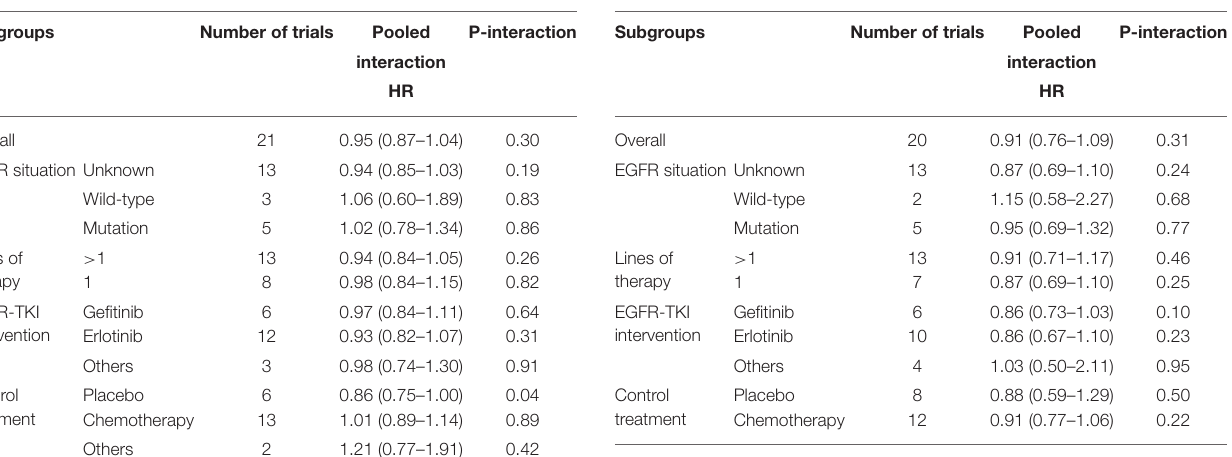
TABLE 3 | Differences in efficacy of EGFR-TKI therapy according to smoking status by